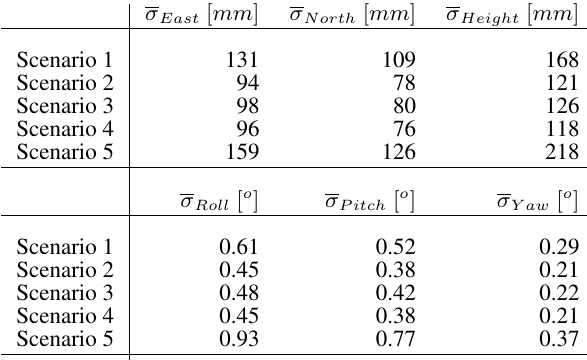
Table 2. Mean precision of the 6 DoF pose over all anchor points of the different